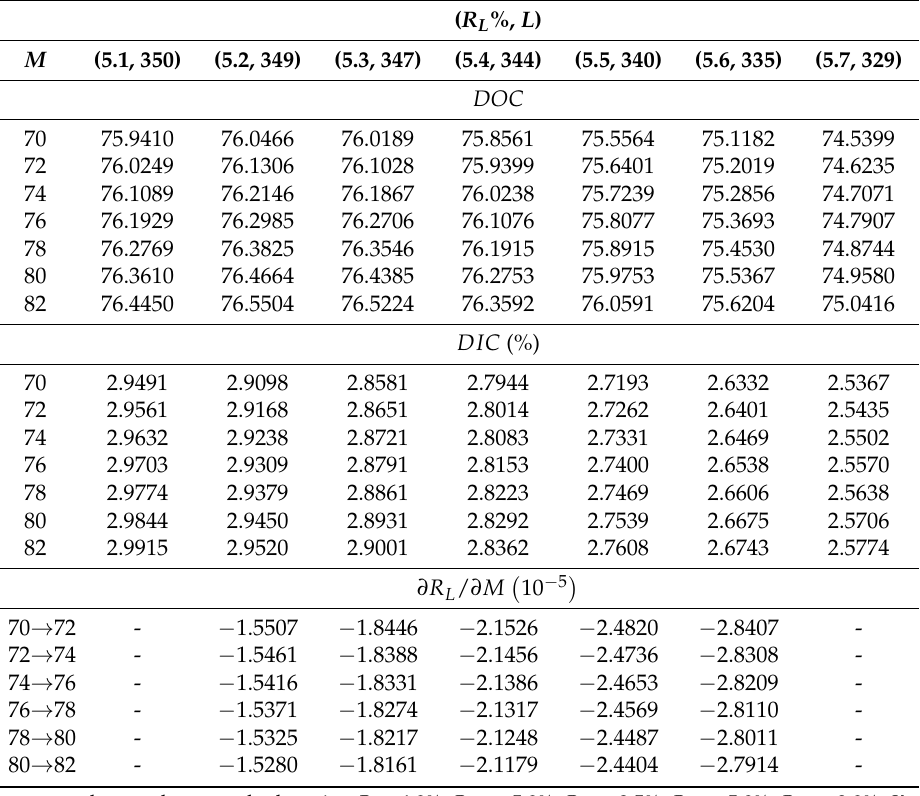
Table 1. Responsiveness of bank interest margin to WMPs 1 .